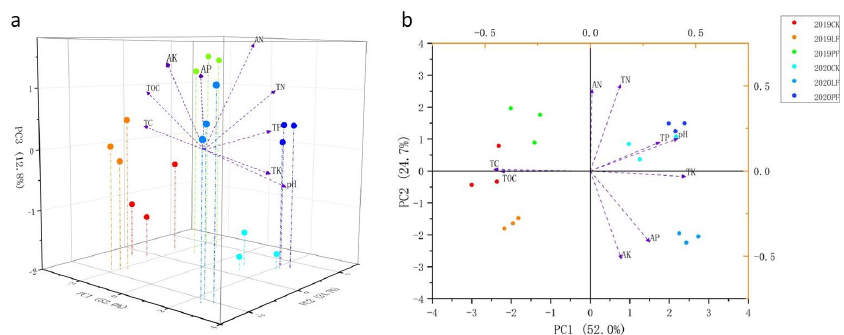
Figure 7. Principal component Analysis (PCA) of soil property index in 2019 and 2020. ( a ): Stereogram including PC1, PC2 and PC3; ( b ): Floor plan including PC1 and PC2.